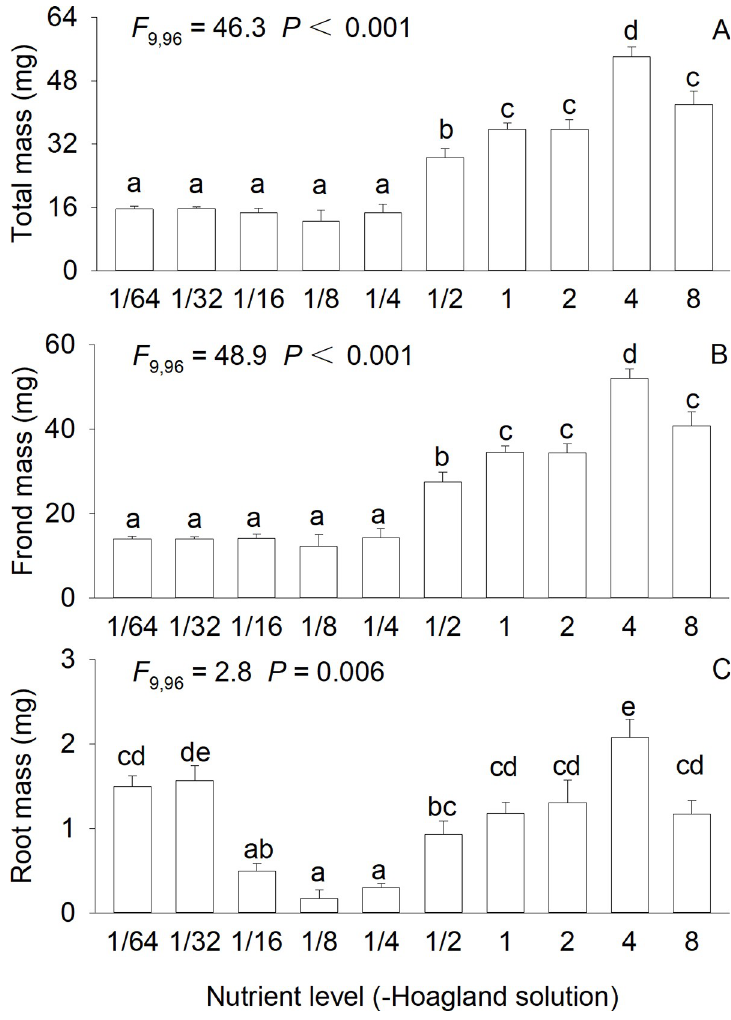
Fig 1. Total mass (A), frond mass (B), and root mass (C) of Spirodela polyrhiza grown in ten concentrations of Hoagland nutrient solution. Bars and vertical lines indicate means and SE (n = 12). F-statistics, df and P-values of one- way ANOVA for the effect of nutrient level are also given. Bars sharing the same letters are not different at P =